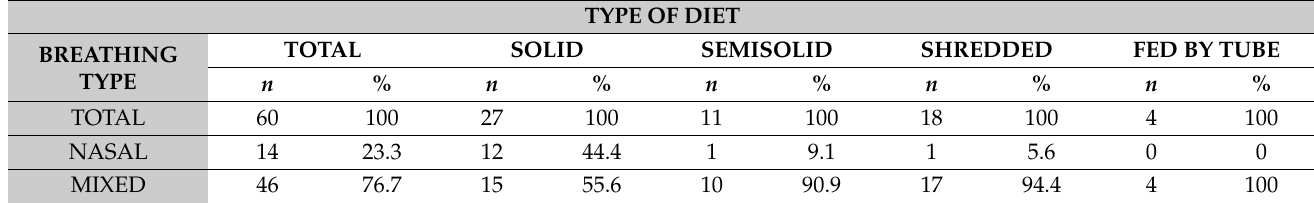
Table 6. Relationship between breathing type and diet type. TYPE OF